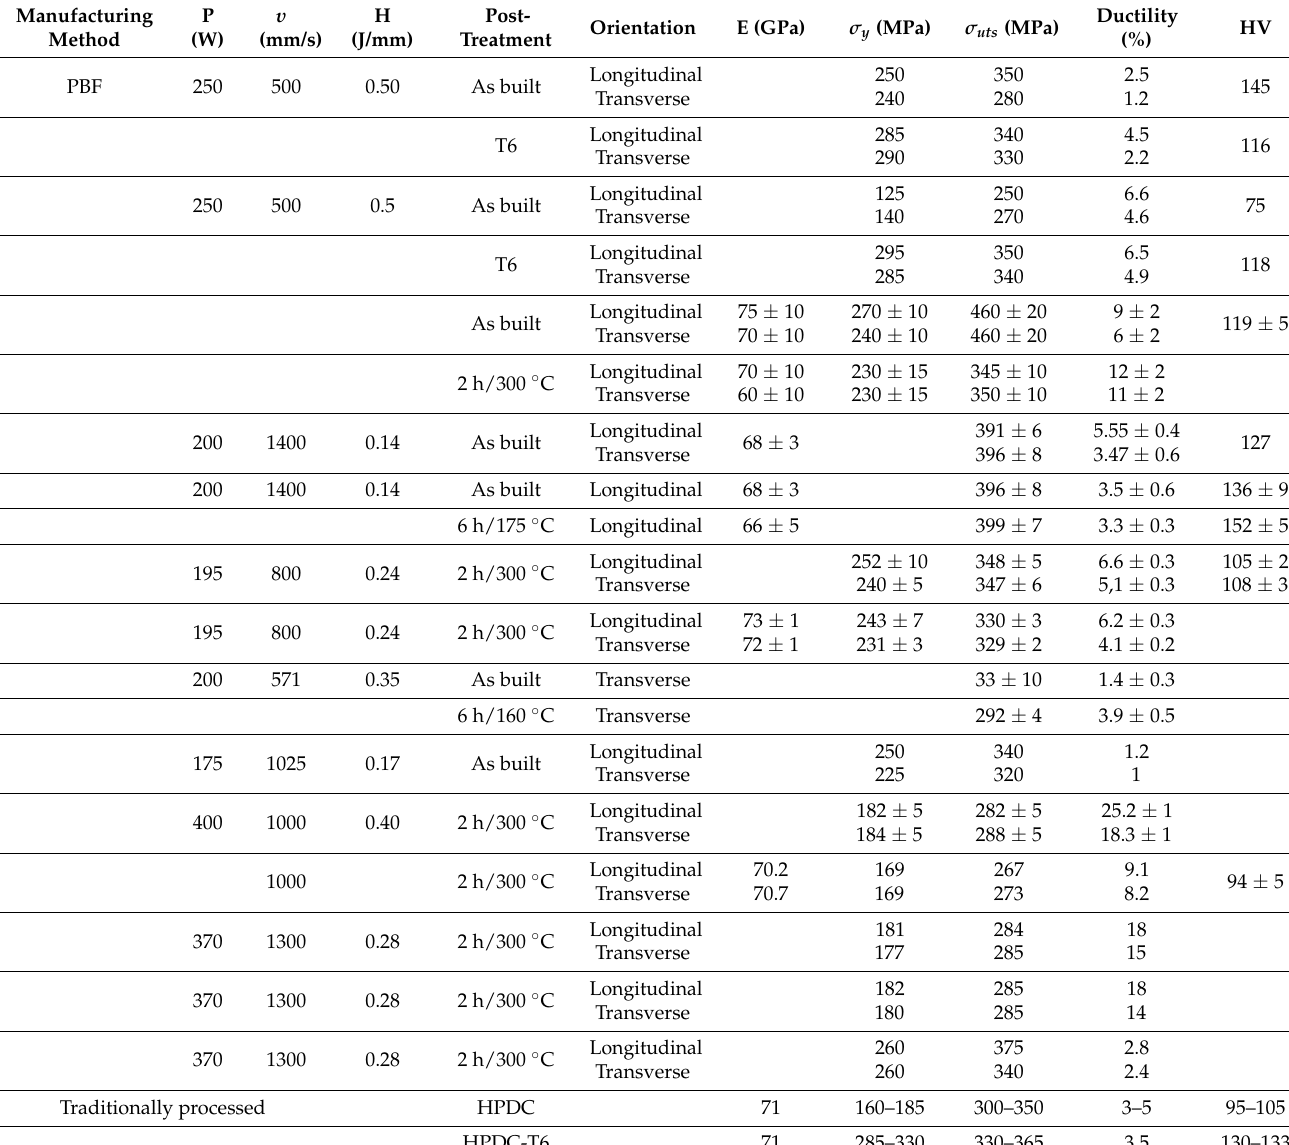
Table 4. Processing parameters and mechanical properties of AlSi10Mg alloys fabricated by AM compared to their traditionally processed counterparts [28]. (P = Laser power, υ = Scanning speed, H = Linear heat input, q = Density, E = Elastic modulus, σ y = Yield strength, σ uts = Ultimate tensile strength, HV = Vickers